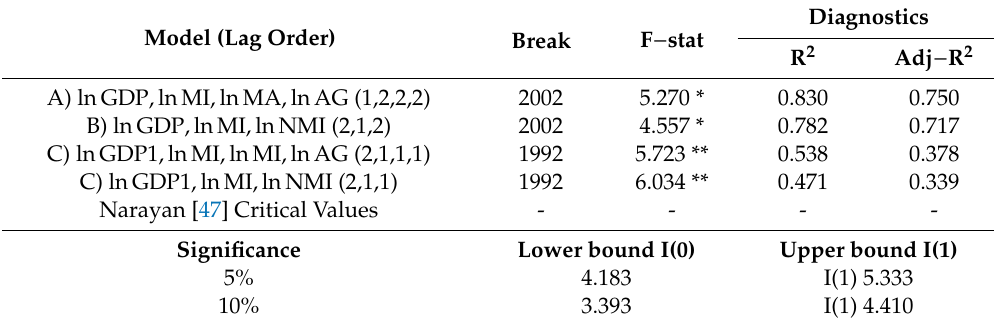
Table 5. Autoregressive Distributed Lag (ARDL) bounds test for co − integration (case 3) results.